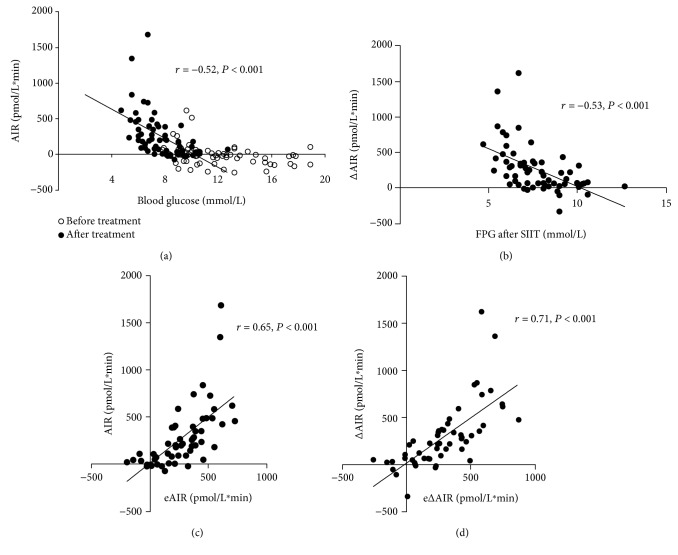
The close association between fasting plasma glucose (FPG) and acute insulin response (AIR). (a) AIR disappeared when FPG > 10 mmol/L, and it was negatively associated with FPG when FPG < 0 mmol/L. (b) FPG after SIIT was negatively correlated with ∆AIR. Performance of the estimating formulae was illustrated by comparing estimated AIR (eAIR) with actual AIR (c), as well as estimated ∆AIR (e∆AIR) with actual ∆AIR, respectively, in patients with FPG < 10 mmol/L after SIIT (n = 56).